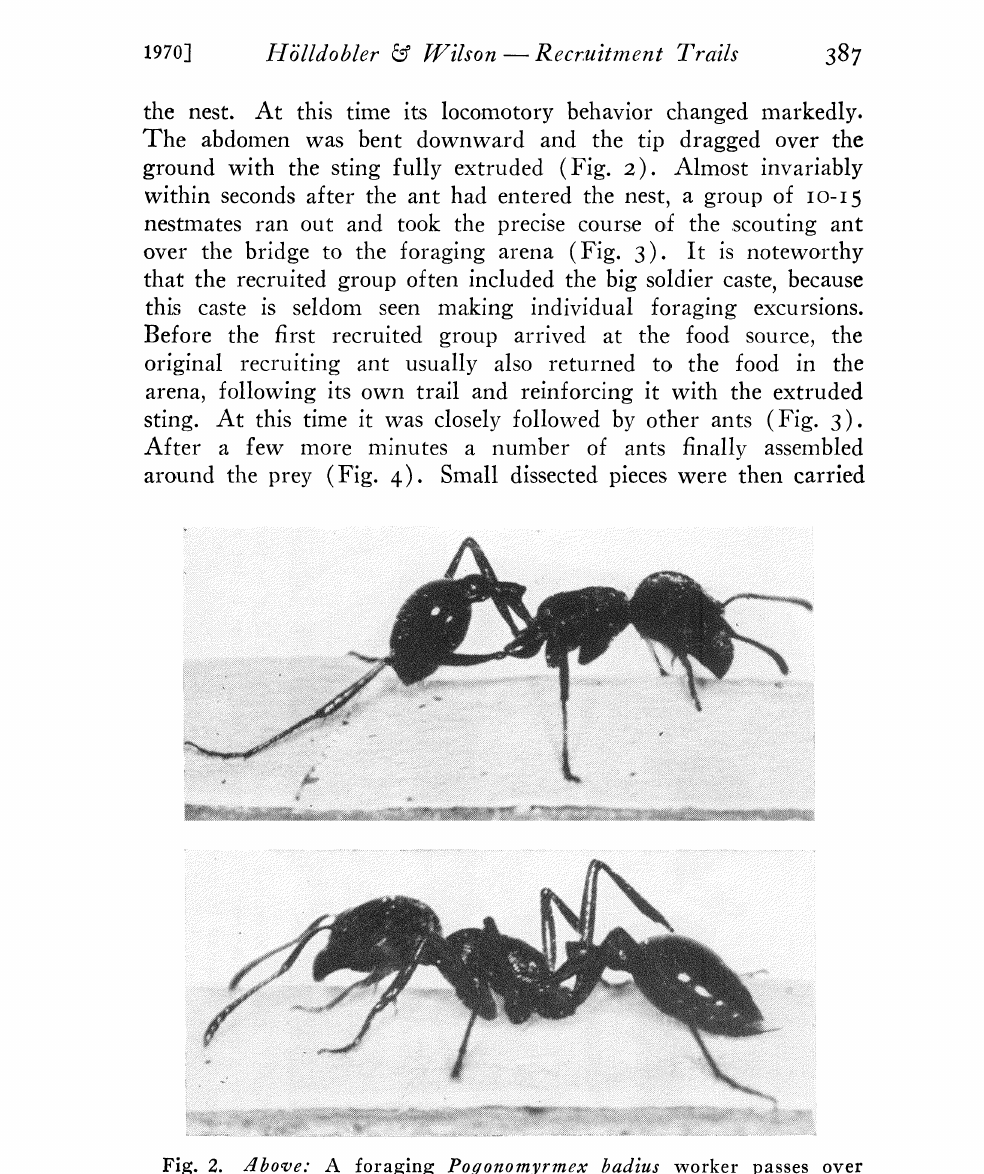
Fig. 2. Above: A foraging Pogonomyrmex badius worker passes over the bridge to the arena. During this searching phase the ant only occasion- ally touches the surface with the tip of its abdomen. Below: After dis- covering a source of food, the scouting ant returns to the nest, dragging the tip of the abdomen over the surface with sting